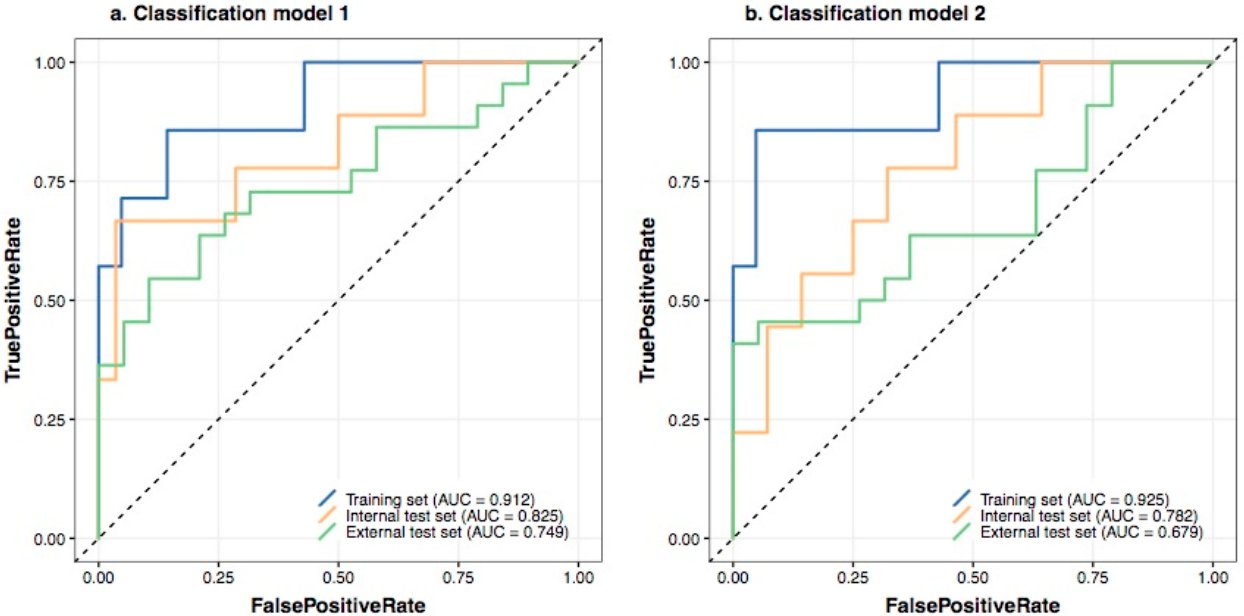
Figure 2. Prediction performance of radiomic classification models in the training set (blue color), internal test set (yellow color), and external test set (green color). ( a ) Classification model 1 with genomics feature selection. ( b ) Classification model 2 without genomics feature selection.